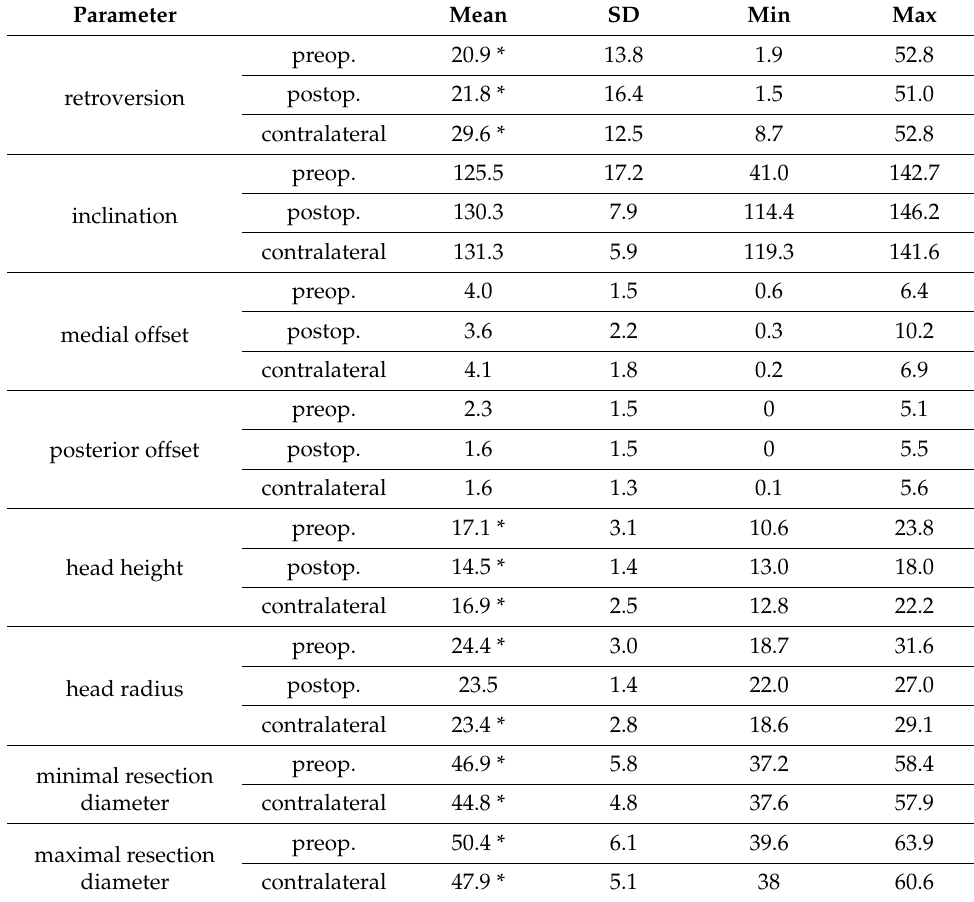
Table 1. Geometrical parameters of humeral joint